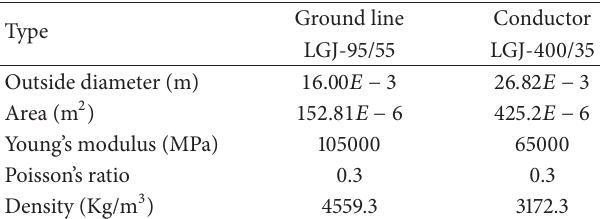
Table 1: Ground line and conductor properties of the suspension